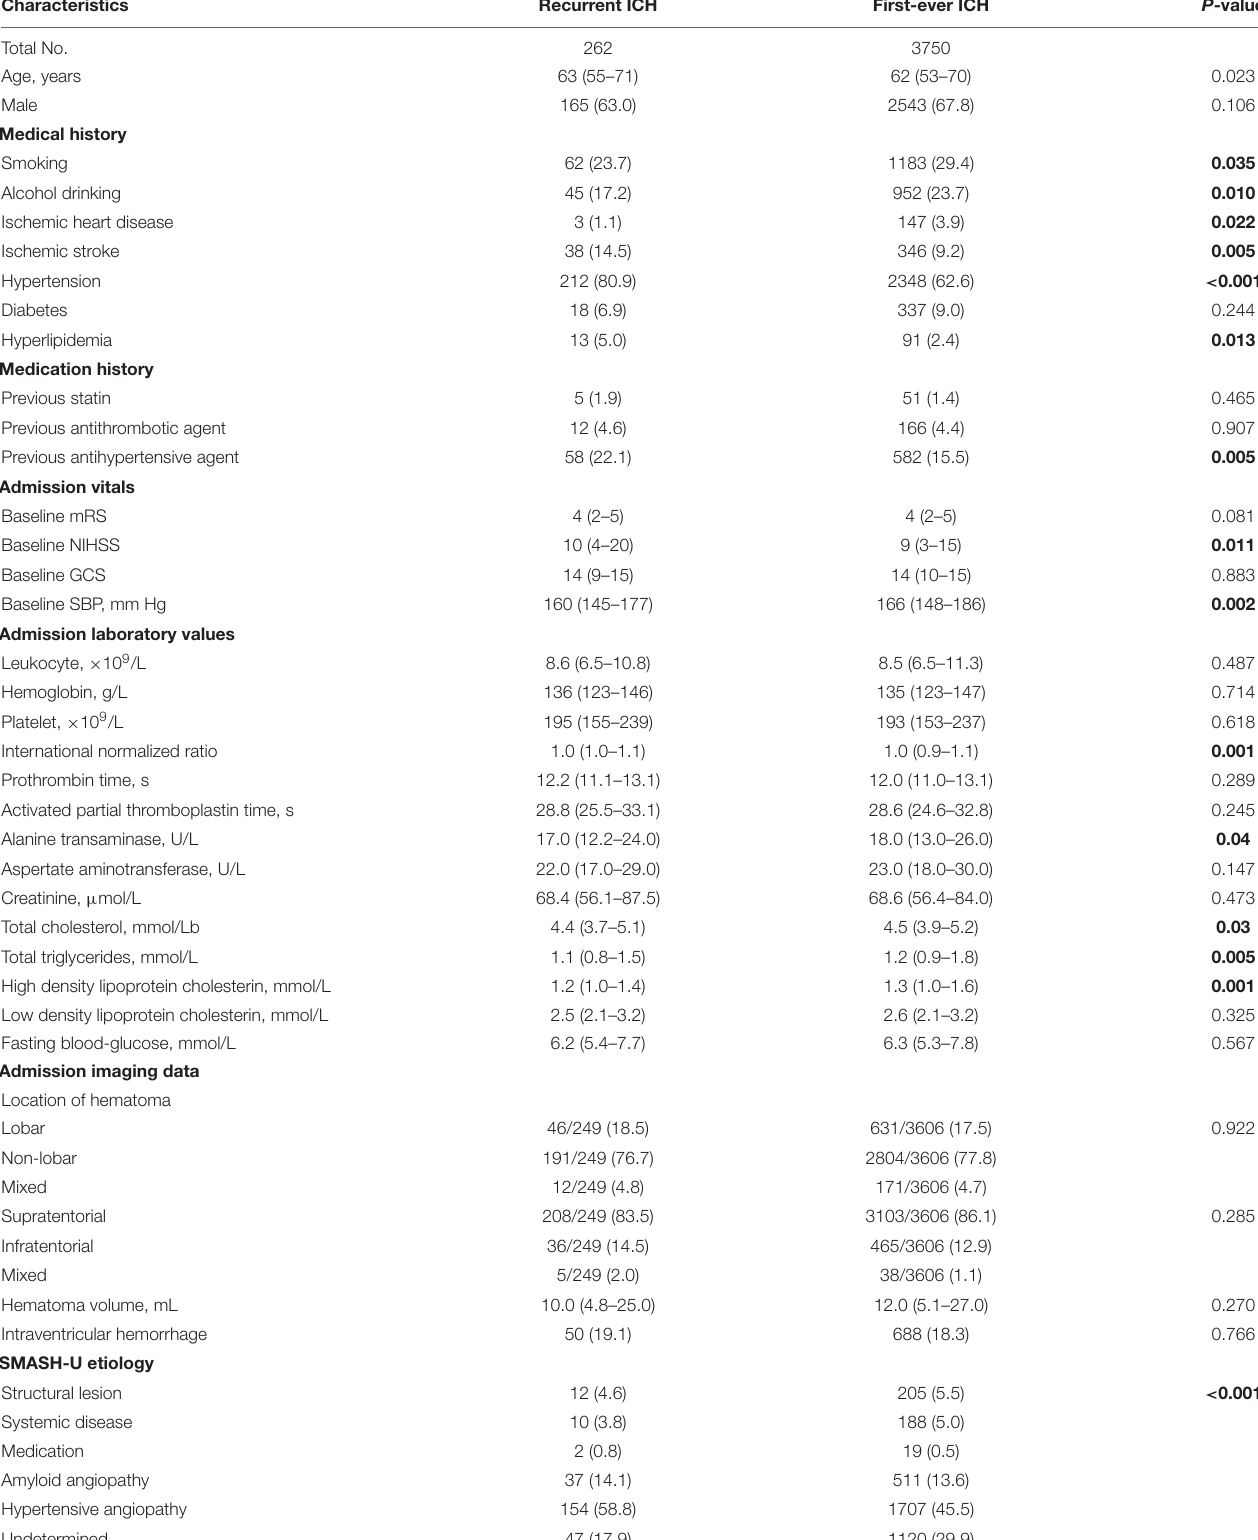
TABLE 1 | Comparisons of demographics and clinical characteristics between patients with first-ever ICH and recurrent ICH. Characteristics Recurrent ICH First-ever